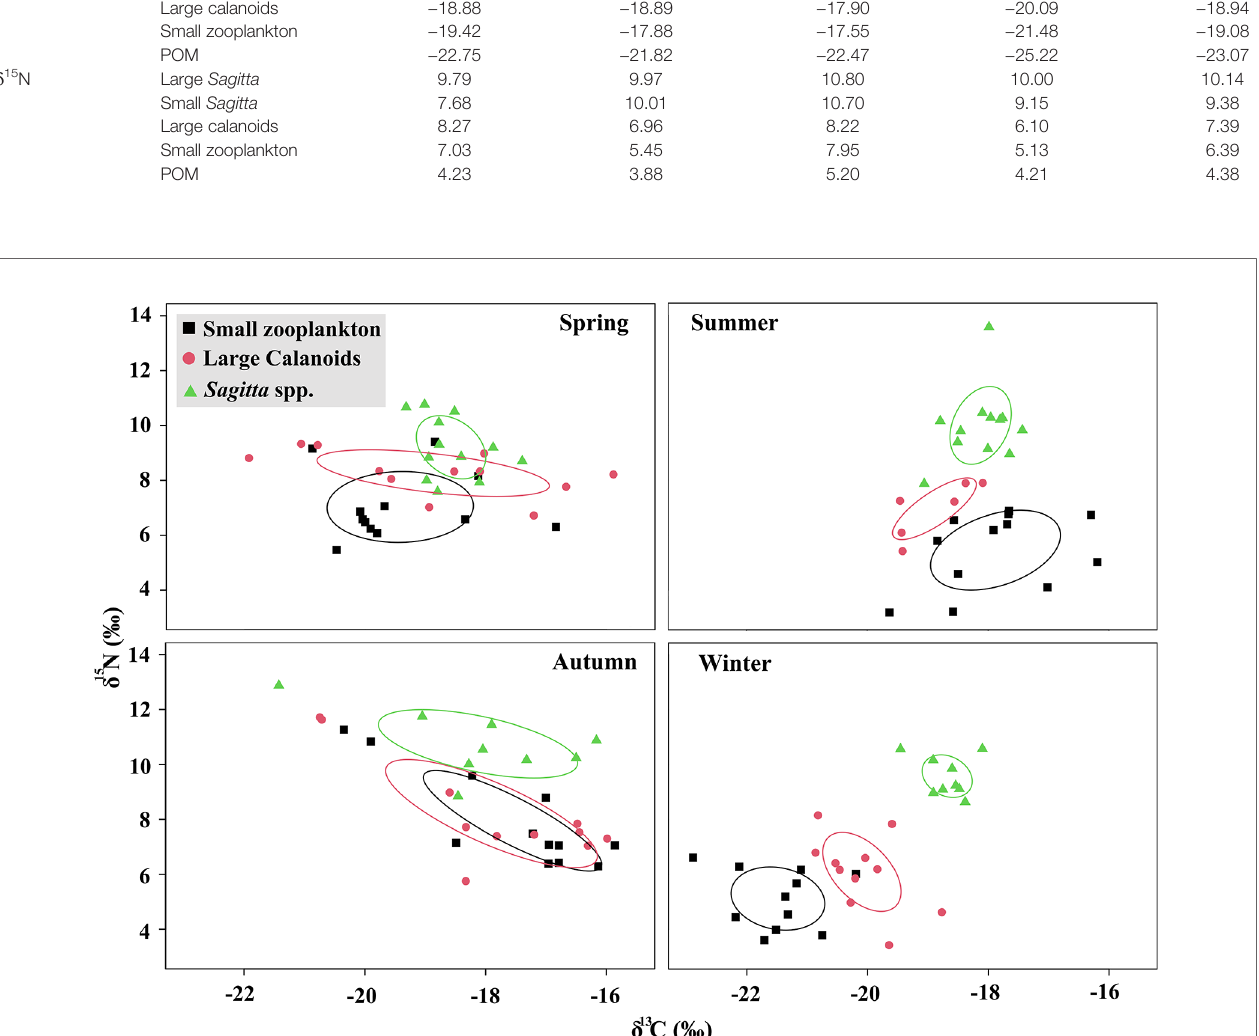
FIGURE 5 | Seasonal variations in the bivariate trophic niche of dominant zooplankton groups represented by Bayesian ellipses in Jiaozhou